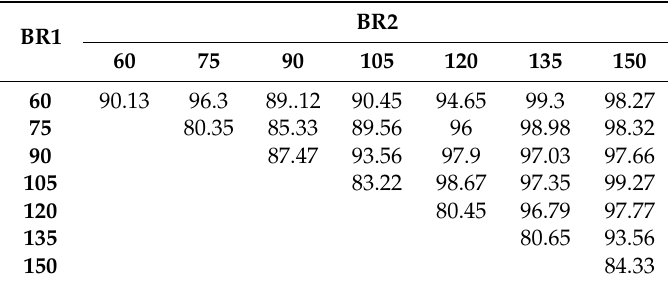
Table 11. Feature fusion detection accuracy—NeroAAC (%).